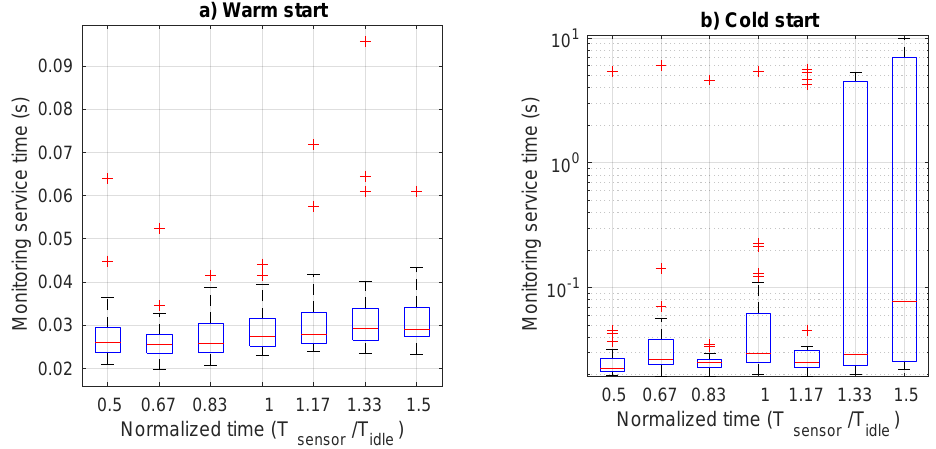
Figure 7. Boxplot of monitoring service time as a function of the normalized transmission period: ( a ) warm start and ( b ) cold start. Figure 8 depicts the mean processing time vs. the normalized data generation period T sensor / T idle . It is interesting to see that, although the warm start curve remains nearly